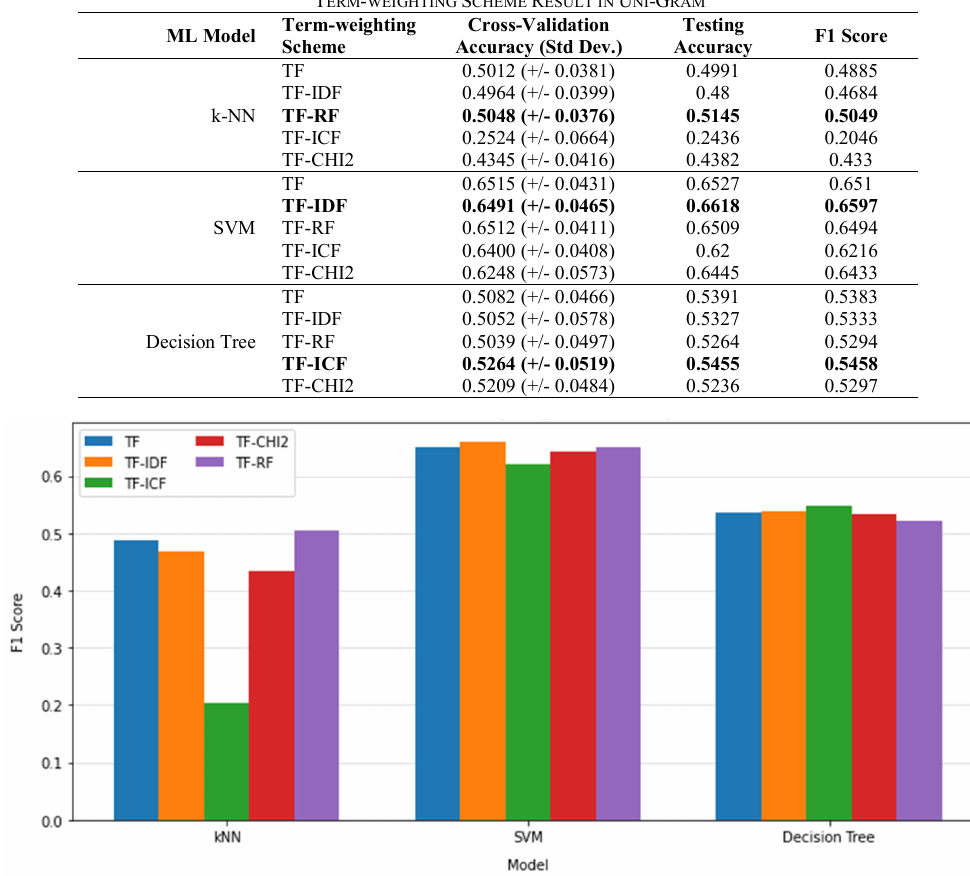
TABLE 1 T ERM - WEIGHTING S CHEME R ESULT IN U NI -G RAM